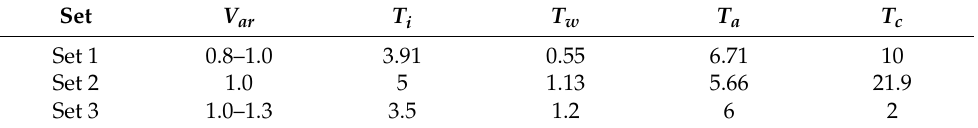
Table 1. Three optimal control sets to simulate the systems ( T c for 2APIOBPCS only). Set V